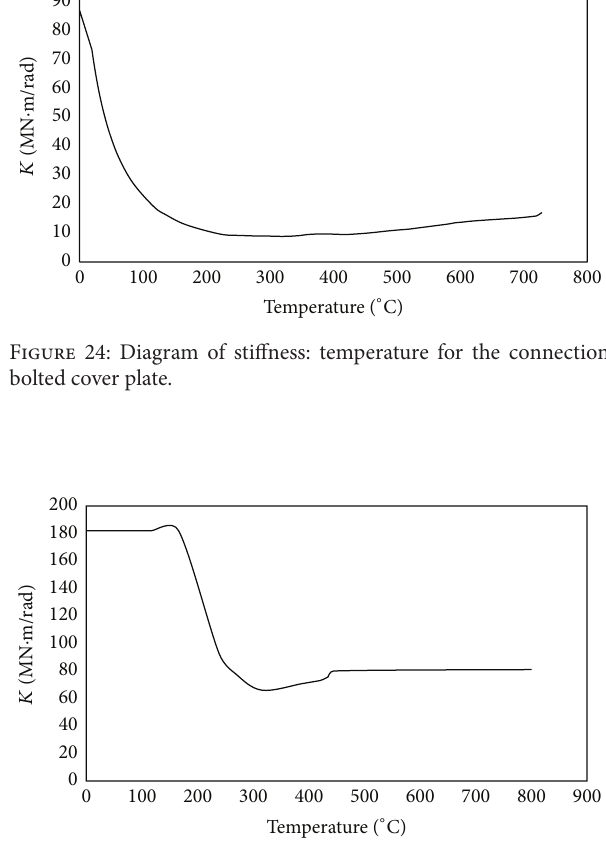
Figure 25: Diagram of stiffness: temperature for the bolted T joint.